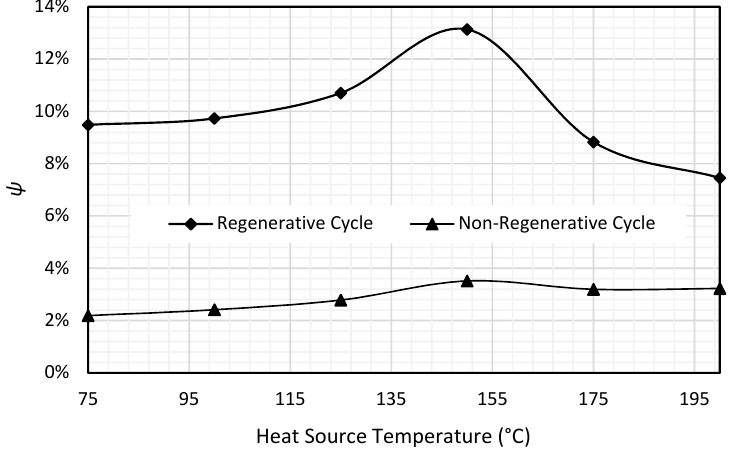
Figure 9. Variation in ψ with changing heat source temperature under Beijing’s ambient conditions.